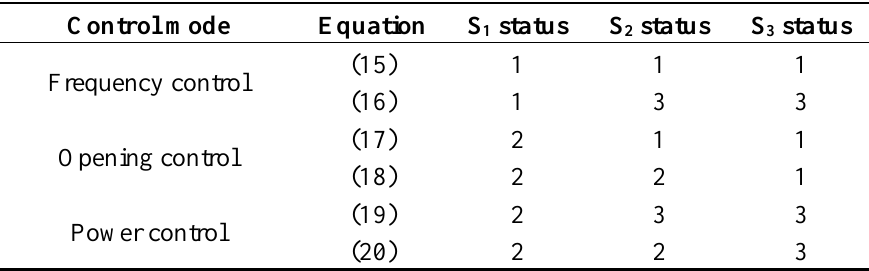
Table 3. Status of selectors in different control modes.